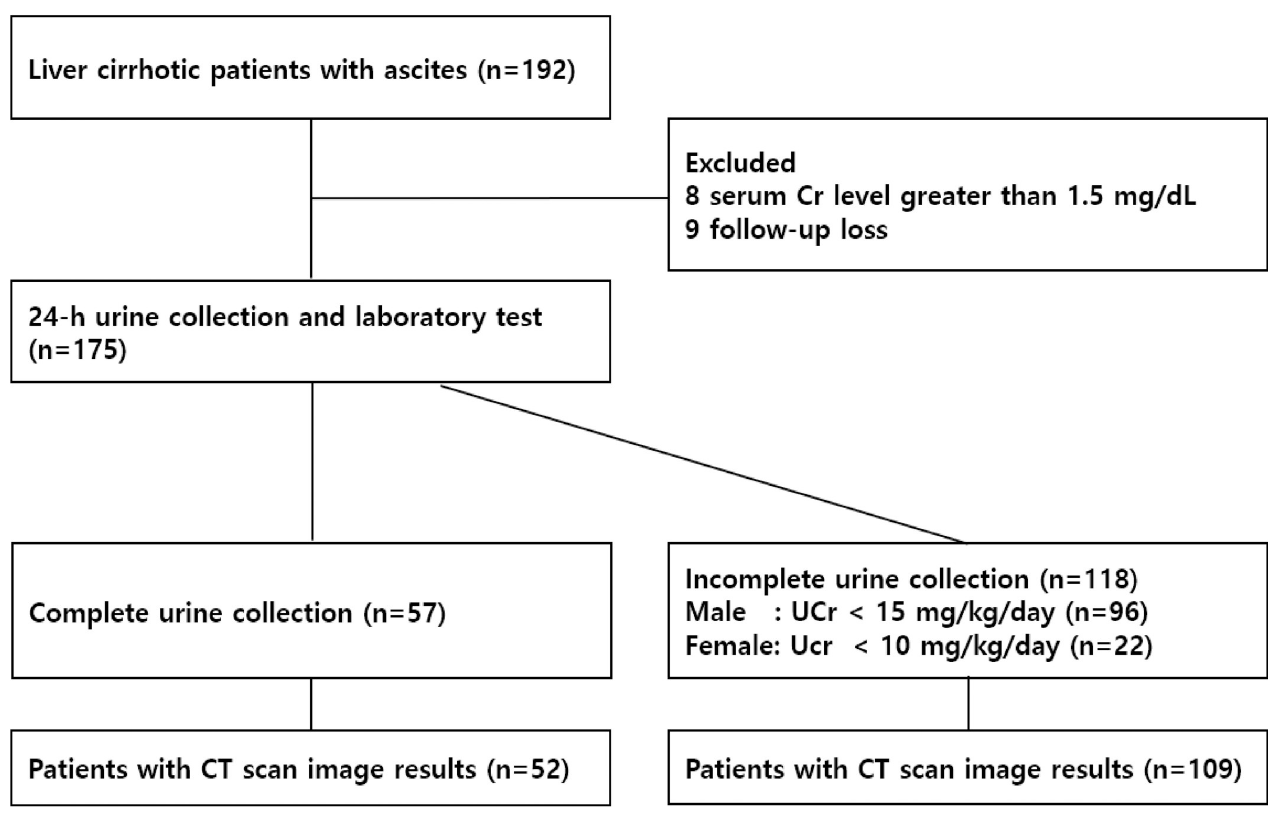
Fig 1. Flow diagram of patient’s participation in the